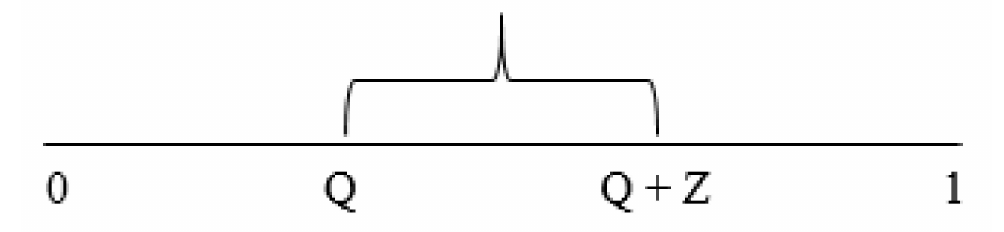
Figure 3. Schematic diagram showing the tiling of the number line for the Markov Chain Monte Carlo